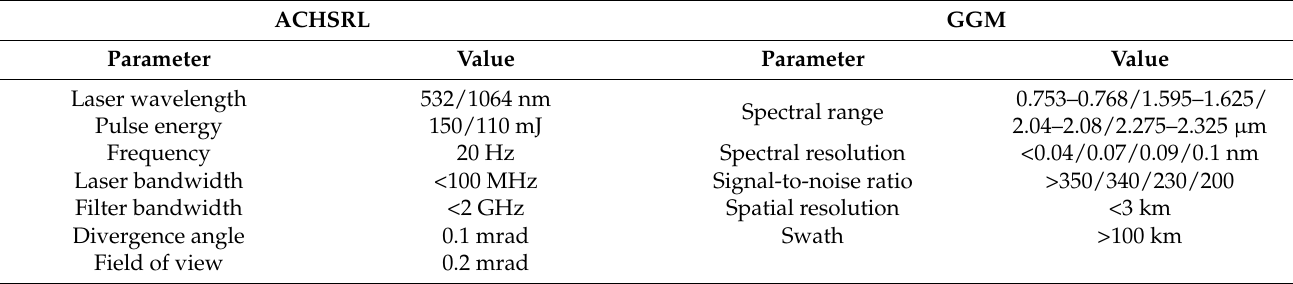
Table 1. Parameters of ACHSRL and GGM of